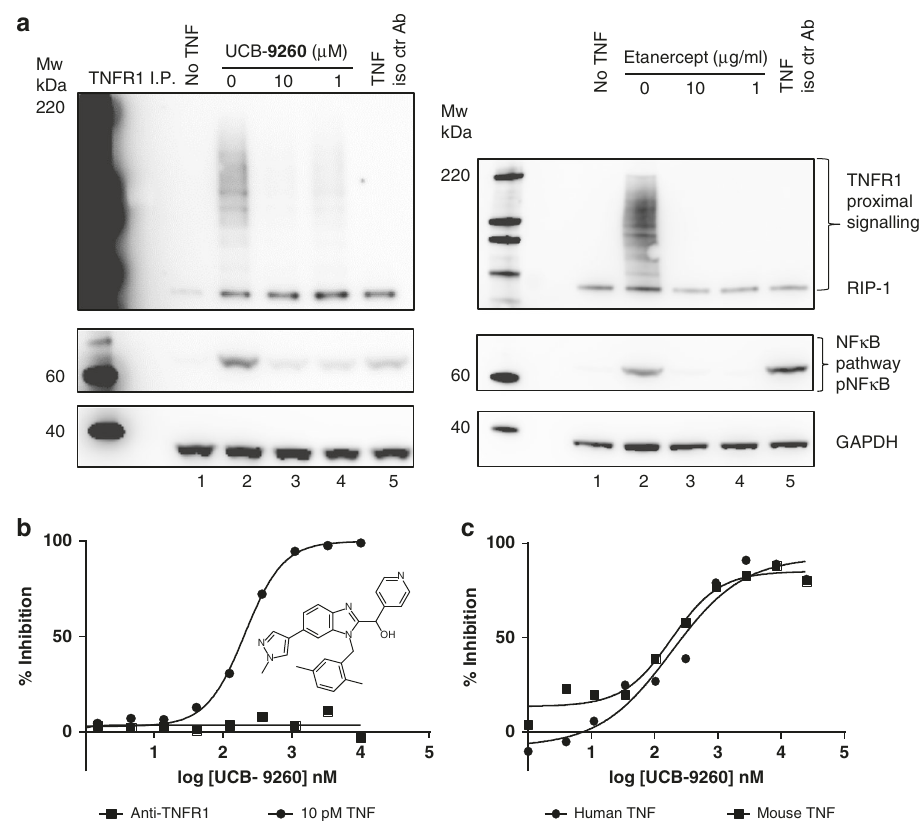
Fig. 5 Inhibition of TNF signalling in cells. a Western blots measuring RIP1 ubiquitination following TNFR1 immunoprecipitation from Jurkat cells treated with TNF±UCB- 9260 or etanercept. pNFkB expression was assessed, along with GAPDH for loading control. An isotype control antibody was included as an immunoprecipitation control (lane 5). b TNF (10pM) or anti-TNFR1 agonist antibody (0.3mg/mL)-driven NFkB activity was measured following UCB- 9260 treatment in Hek-293 cells using a reporter gene assay system. Representative concentration-response curves are shown. Percentage inhibitions for compound dilutions were calculated between a DMSO control and maximum inhibition (by excess biologic anti-TNF, or NFkB inhibitor – TPCA-1). Untransformed data shown in Supplementary Fig. 10c. c UCB- 9260 inhibition of TNF (human or mouse) dependent cytotoxicity was measured in mouse L929 cells. Representative concentration-response curves are shown. Percentage inhibition was calculated between unstimulated wells (maximum signal), and wells with TNF, DMSO and actinomycin D (minimum signal). Untransformed data shown in Supplementary Fig. 10d. Source data are provided as a Source Data fi